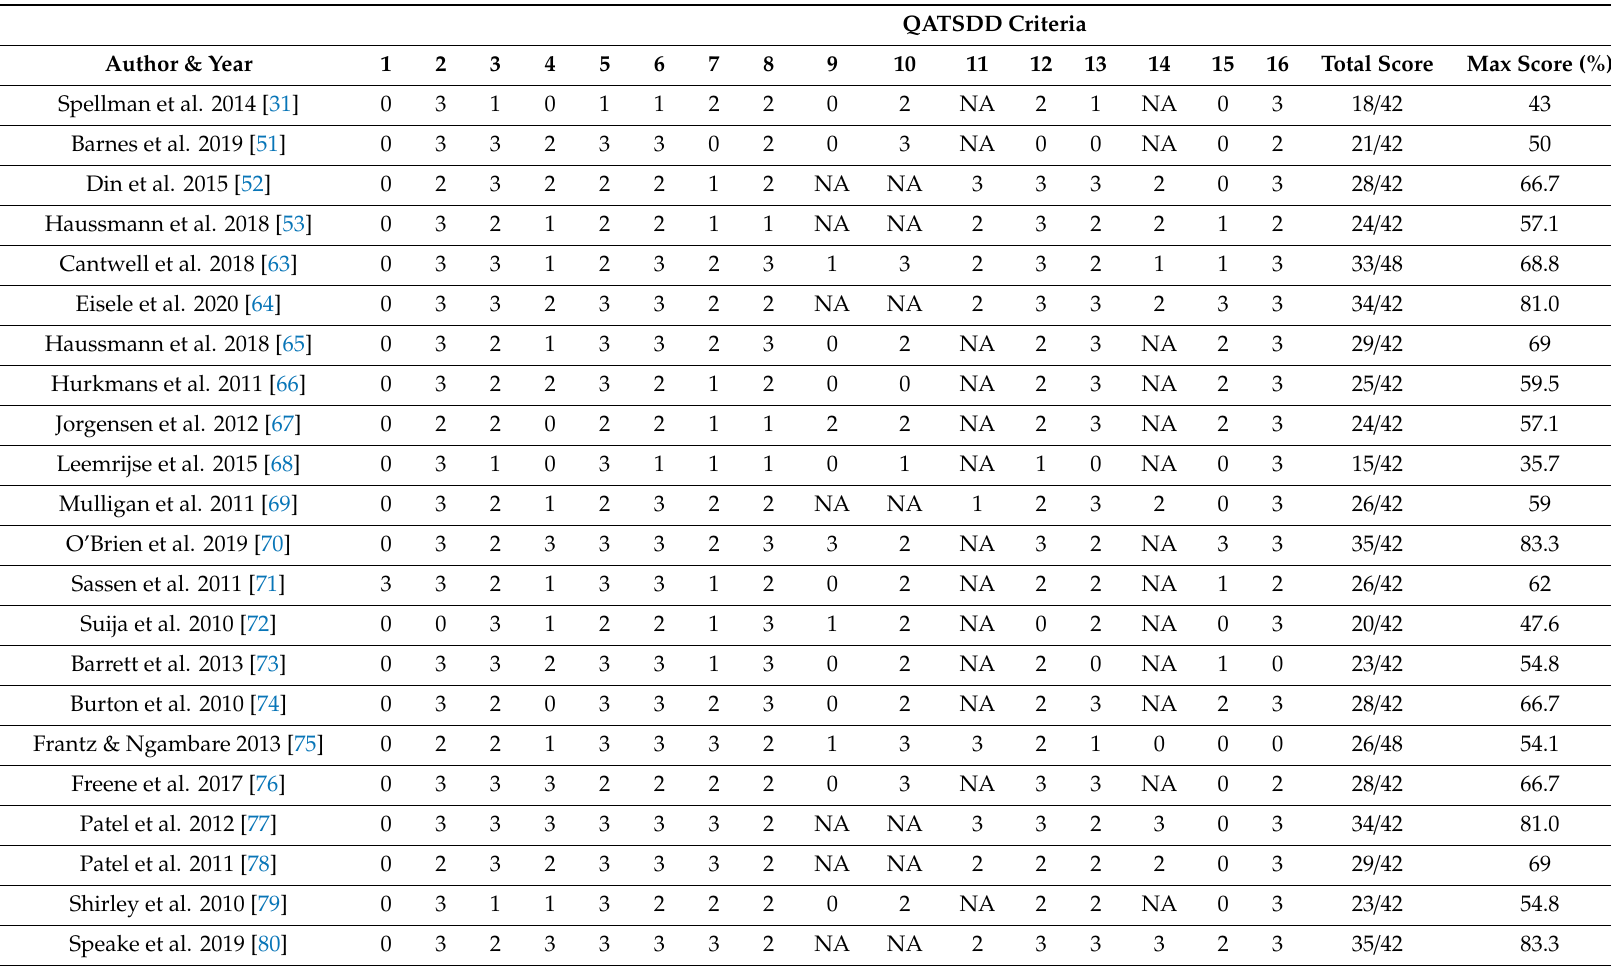
Table 4. Quality assessment of the included